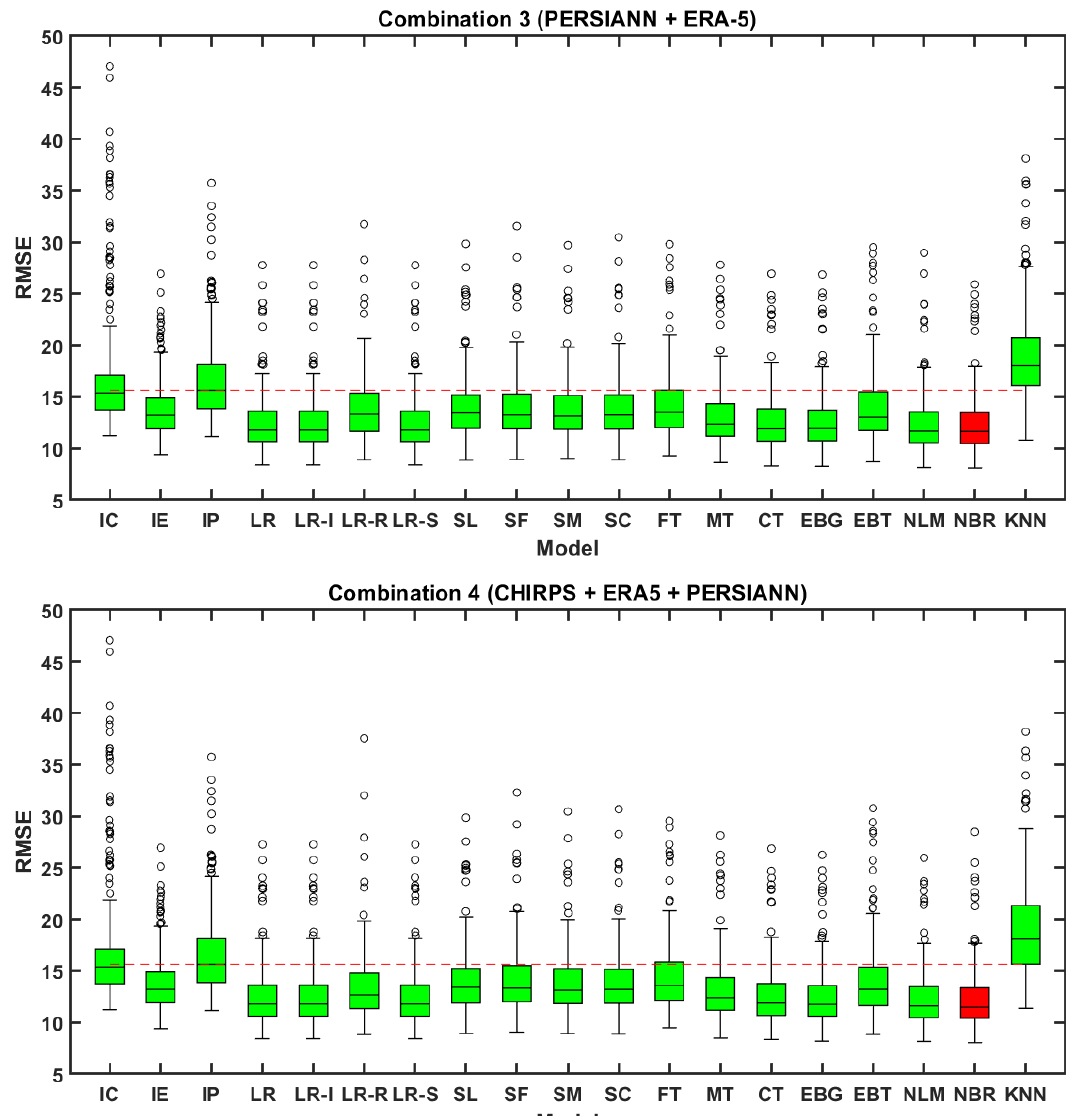
Figure 5. Boxplots representing the performance of individual and integrated precipitation dataset under four combinations in terms of root mean square error (RMSE) (IC represents IMD vs. CHIRPS, IE represents IMD vs. ERA-5, and IP represents IMD vs. PERSIANN CDR).